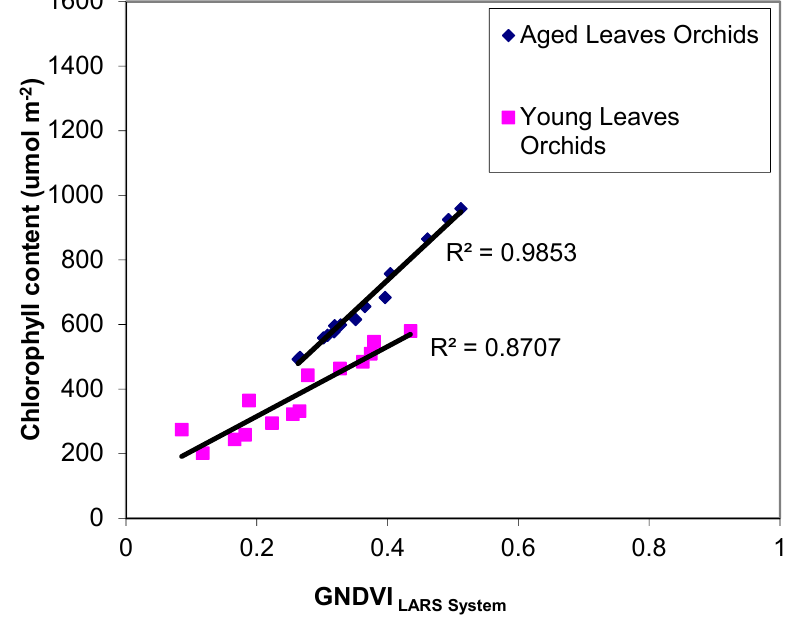
Figure 8. Leaf chlorophyll content estimation from leaf reflectance (green normalized differential vegetation index—GNDVI) for aged and young orchids (healthy).